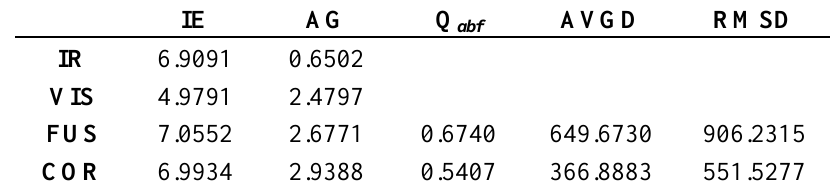
Table 3. Quantitative analysis of IR and VIS image fusion and correction (1300 LST 24 July 2006).